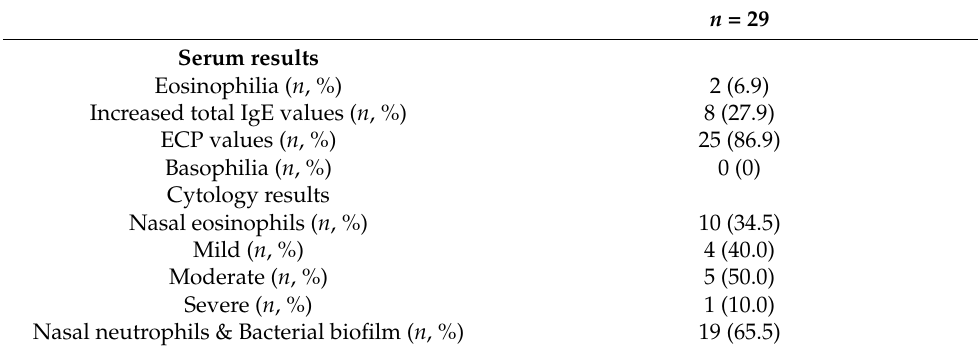
Table 2. Serum and nasal cytology results of the study population.